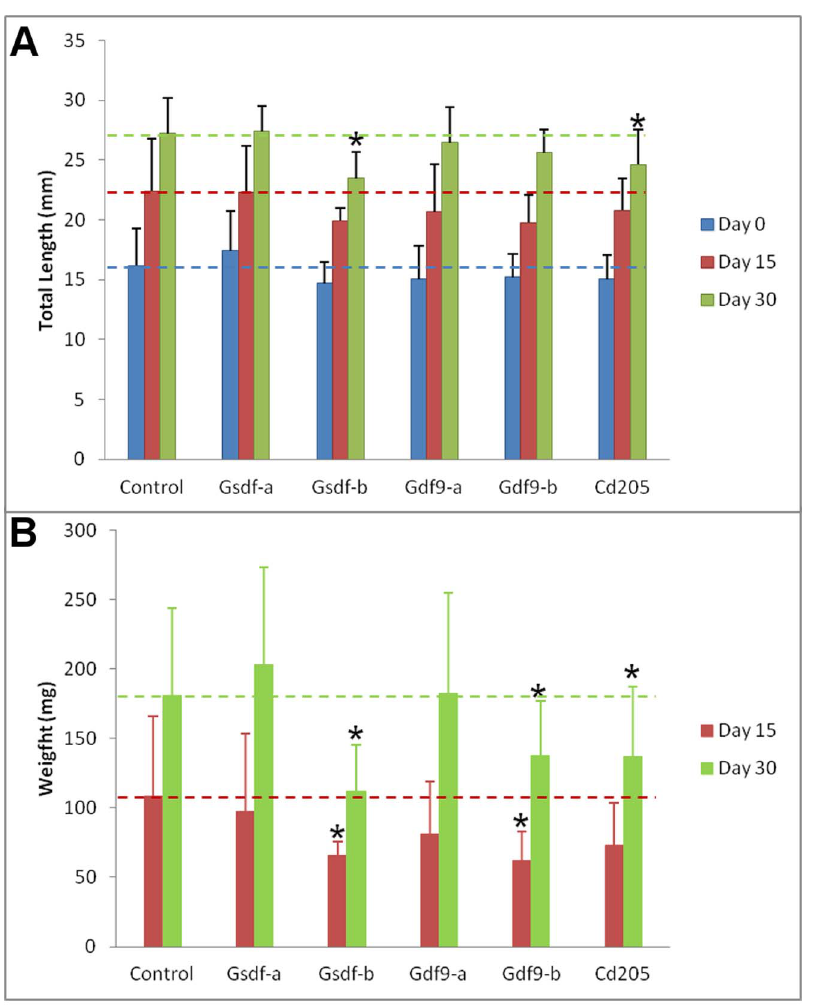
Figure 3. Total length (A) and weight (B) of fish over the course of the experiment. Weight at the start of treatment (day 0) was not measured. Stars represent a statistically significant difference from the control group (ANOVA, LSD test at p , 0.05) at the given time point. Error bars represent standard